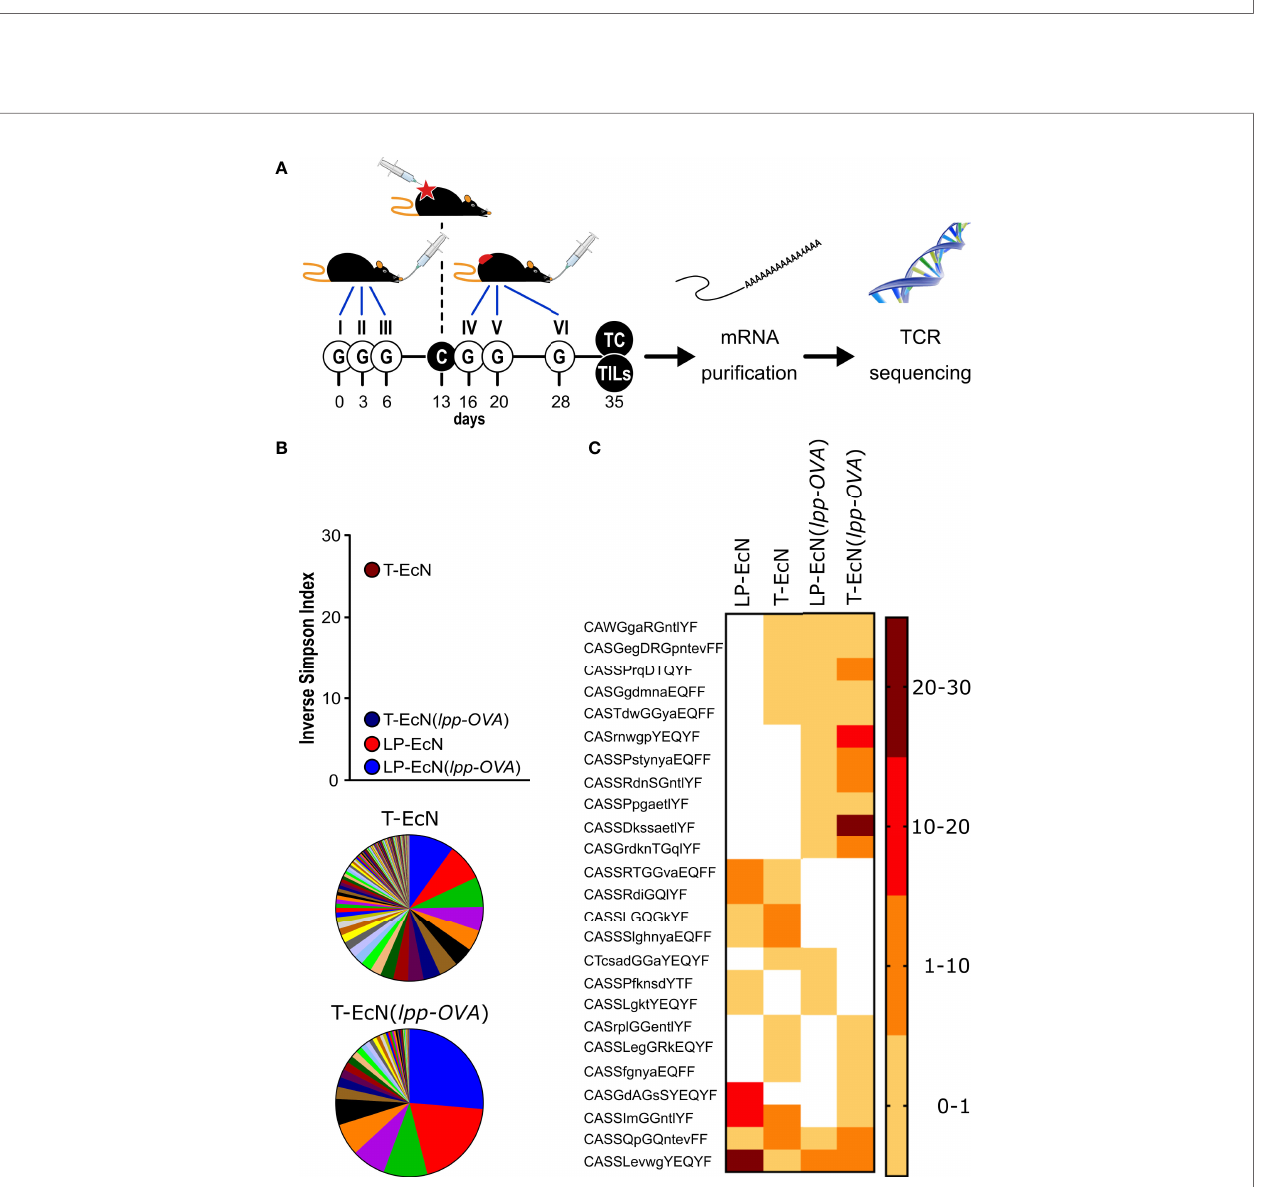
FIGURE 3 | Analysis of Tumor In fi ltrating Lymphocytes (TILs) by fl ow cytometry and immuno fl uorescence – At the end of the experiment depicted in Figure 1D, tumors were collected and analyzed by fl ow cytometry and IF. The fi gure reports the fl ow cytometry analysis of OVA-speci fi c CD8 + T cells (one representative graph from the analysis performed on four tumors per group; for cell count, see details in Supplementary Table 5 ) and IF (one tumor from EcN (A) and one tumor from EcN( lpp-OVA ) (B) group). For IF, tumors were fi xed and frozen sections were analyzed for OVA-speci fi c CD8 + T cells (red stained cells) detection using OVA 257-264 Dextramer labeled with pycoerythryn. Total CD8 + T cells (green stained cells) were also visualized by fi xing frozen sections in acetone followed by incubation with anti-mouse CD8 rat monoclonal antibody and goat anti-rat Alexa-Fluor 488 conjugate antibody. FoxP3 + cells were analyzed using Rat monoclonal antibody anti- Mouse FoxP3-FITC conjugate (green stained cells). The images report the analysis of FoxP3 + cells with an overall view (bottom left) and three zoom-ins of the highlighted areas (bottom right). Numbers for T cell count/mm 2 represent the average and standard deviation from the analysis of 6 sections for CD8 + and OVA + staining and 10 sections for FoxP3 +